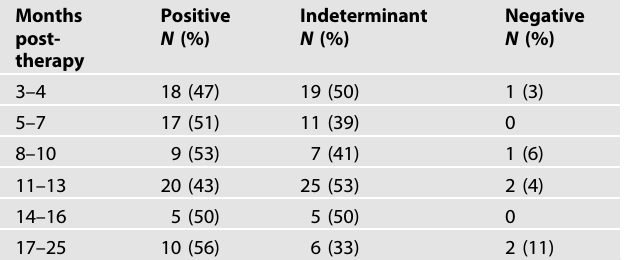
Table 1. Immunohistochemical detection of MRD in Bone marrow after cladribine (Adapted from Ellison, DJ, Blood,